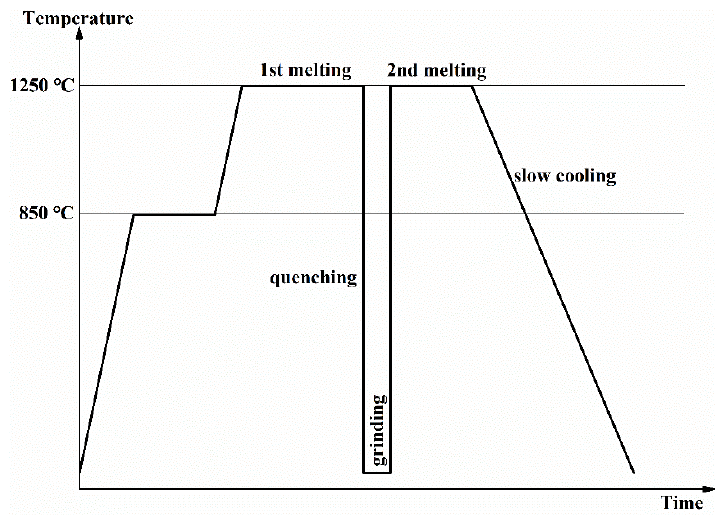
Figure 1. Schematic diagram of different stages of glass-ceramics preparation.